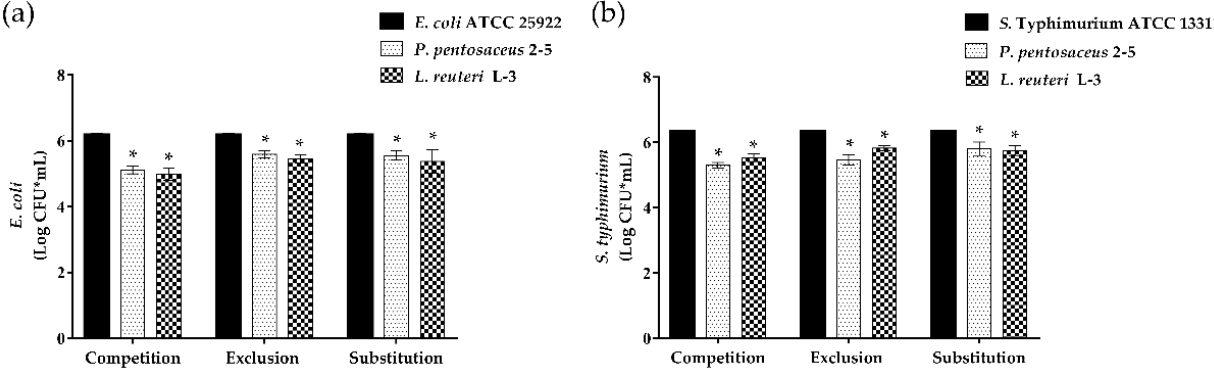
Figure 8. The ability of P. pentosaceus 2-5 and L. reuteri L-3 to inhibit the adhesion of enteropathogens to Caco-2 cell lines. Caco-2 cells were incubated with E. coli ATCC 25922 and S. Typhimurium ATCC 13311 alone as a control: ( a ) The ability of strains to inhibit the adhesion of E. coli ATCC 25922. ( b ) The ability of strains to inhibit the adhesion of S. Typhimurium ATCC 13311. The results represent the mean ± SD of three independent experiments. The significant difference was indicated by asterisks compared to the control: * p <0.05.